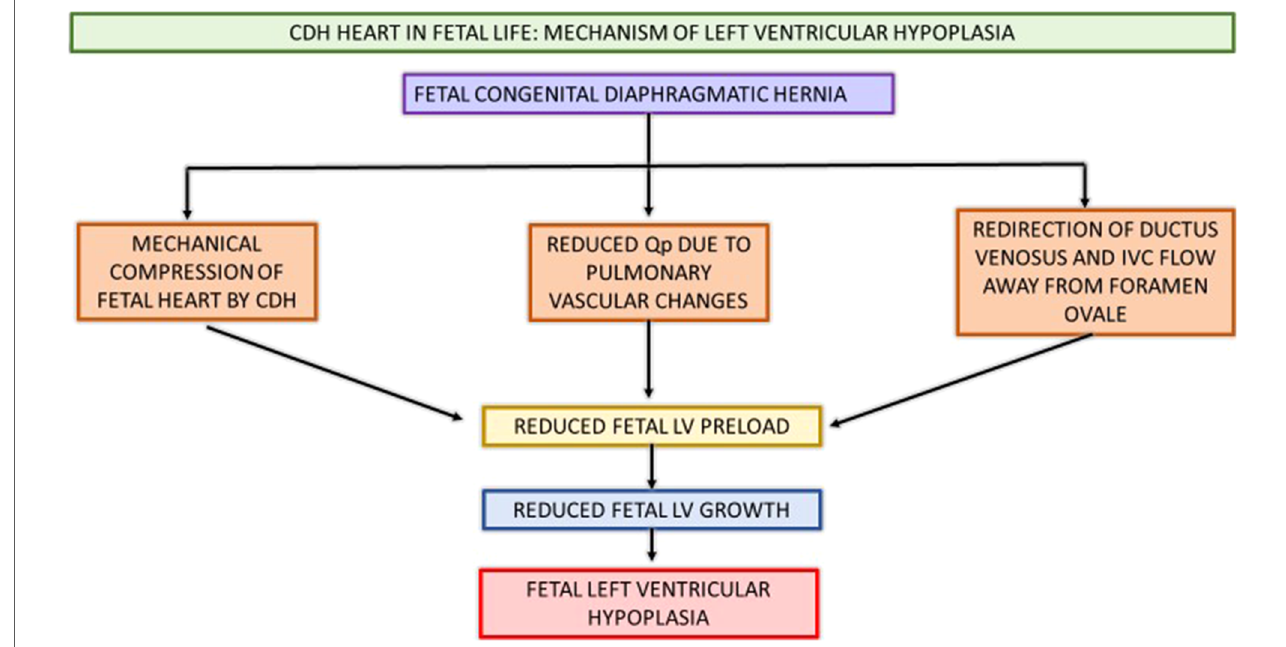
FIGURE 3 Schematic showing CDH heart in fetal life and pathophysiology contributing to postnatal LV hypoplasia and systemic hypotension. CDH, congenital diaphragmatic hernia; Qp, pulmonary blood fl ow; IVC, inferior vena cava; LV, left ventricle.